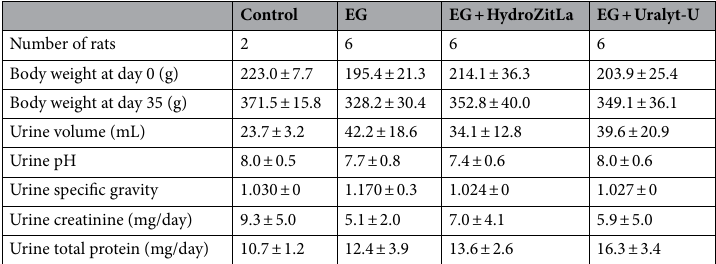
Table 1. Characteristic of 24-h urine (Day 35) of the experimental rats.